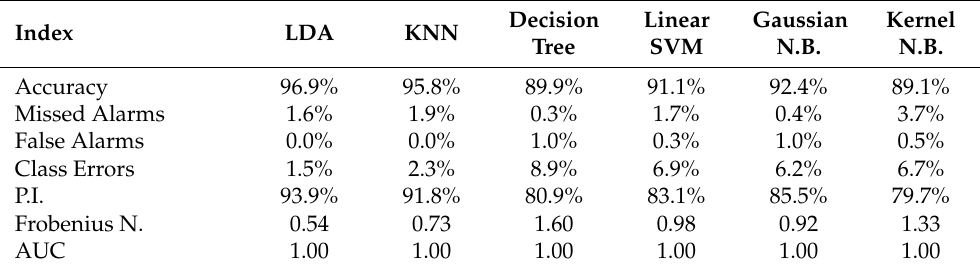
Table 3. Comparison indices obtained with the features calculated thanks to the Multi-ND method optimized by means of GA.